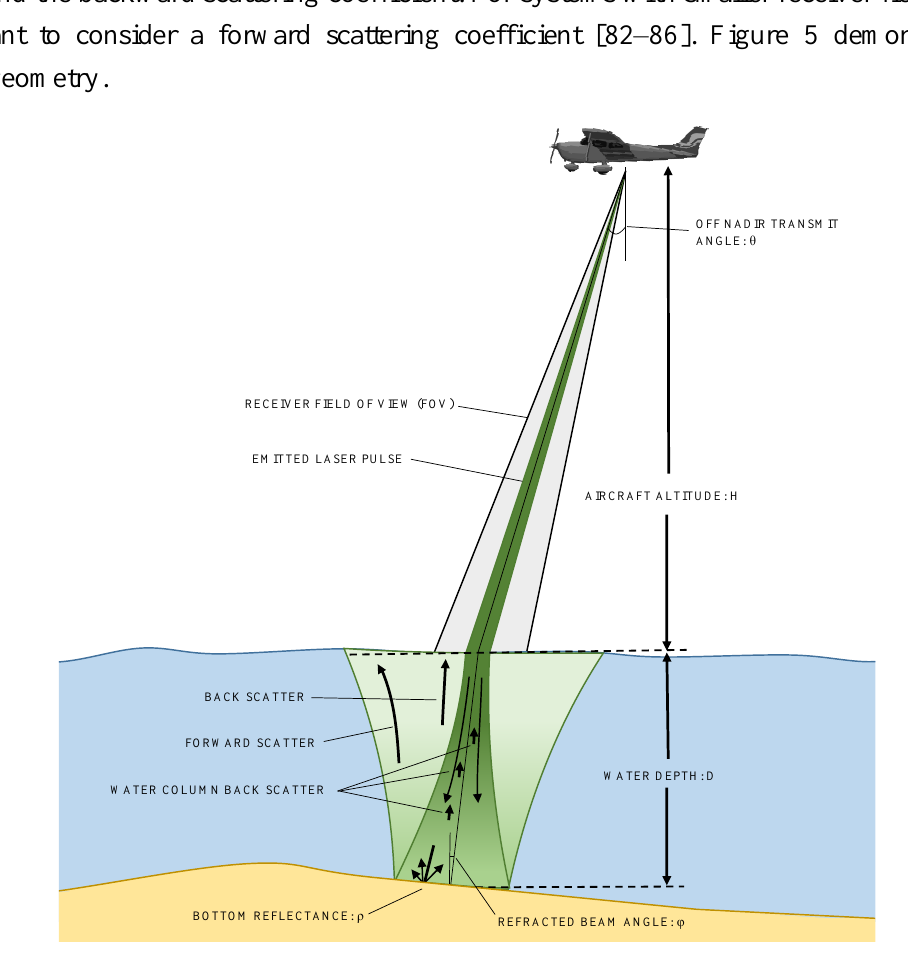
Figure 5. Bathymetric LIDAR acquisition geometry (adapted from [74]). Table 3. Effective factors influencing bathymetric LIDAR intensity